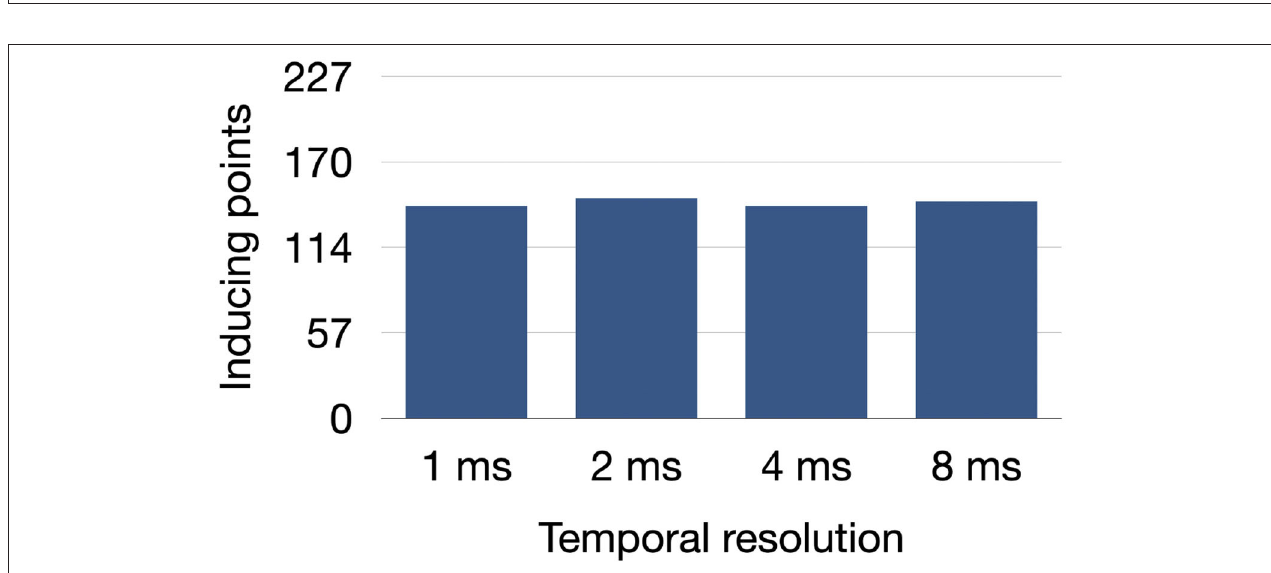
FIGURE 8 | Number of inducing points identified in the model UIV when decreasing the temporal resolution used to find the local effective refractory period in the PEERP